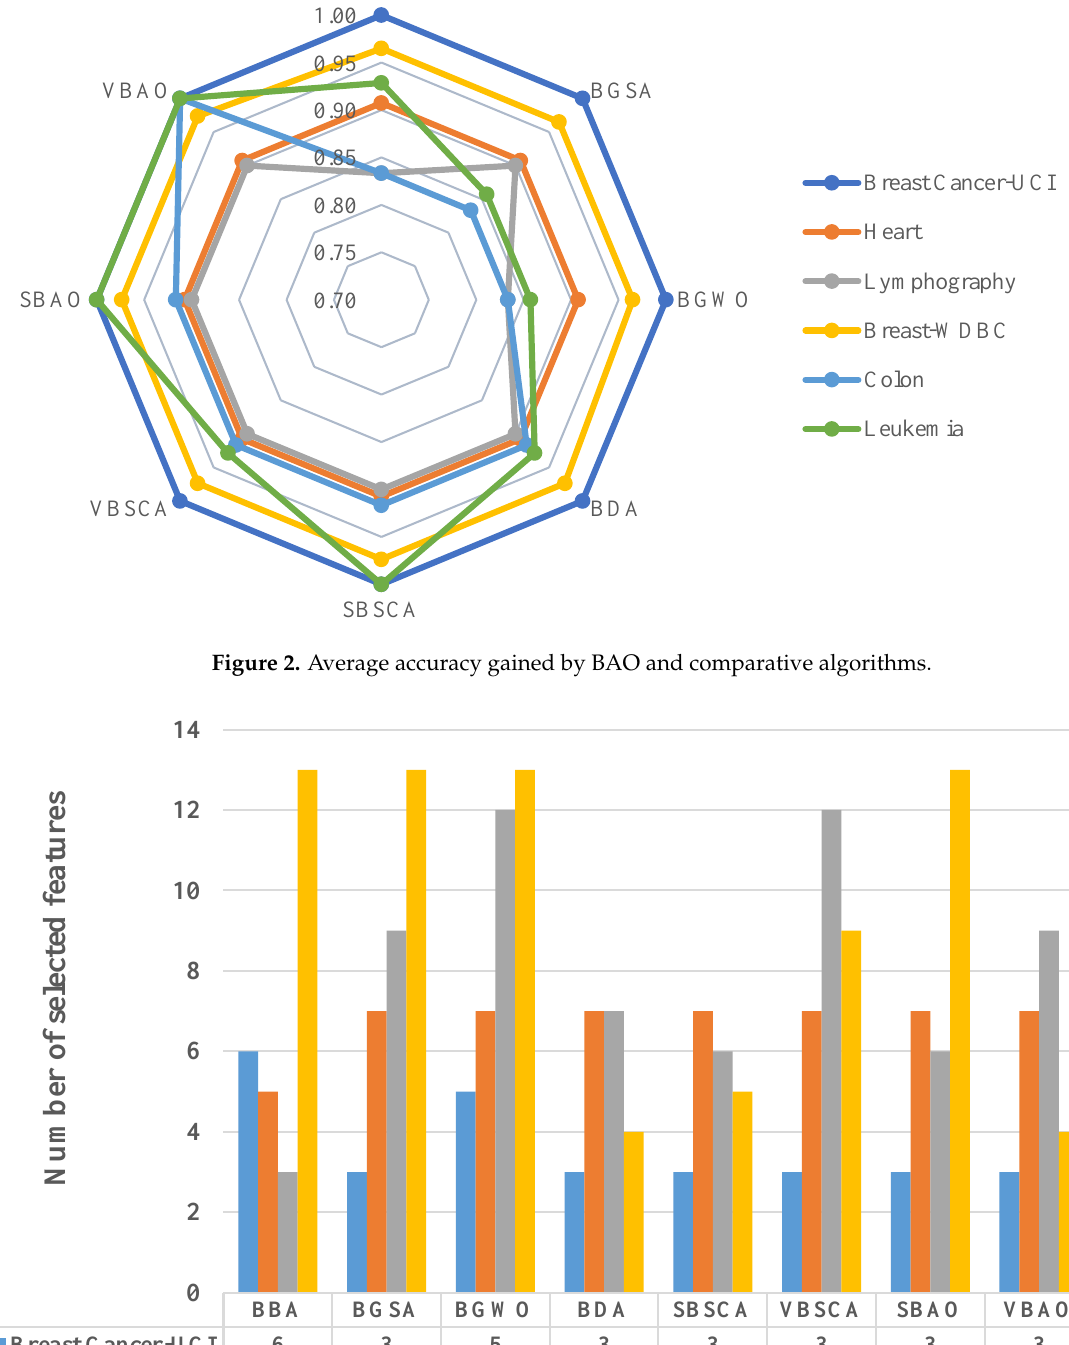
Figure 4. The Number of selected features comparison on large datasets.